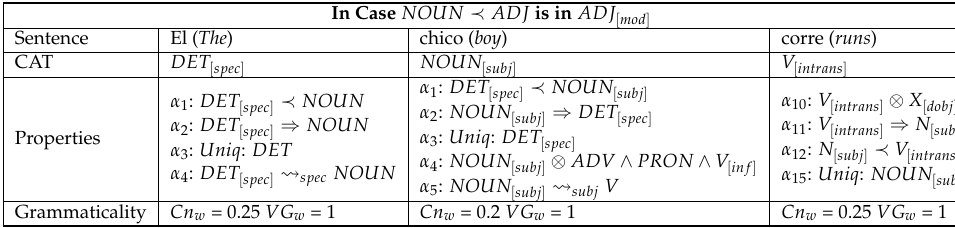
Table 10. Example of not including NOUN ≺ ADJ in NOUN [ subj ]